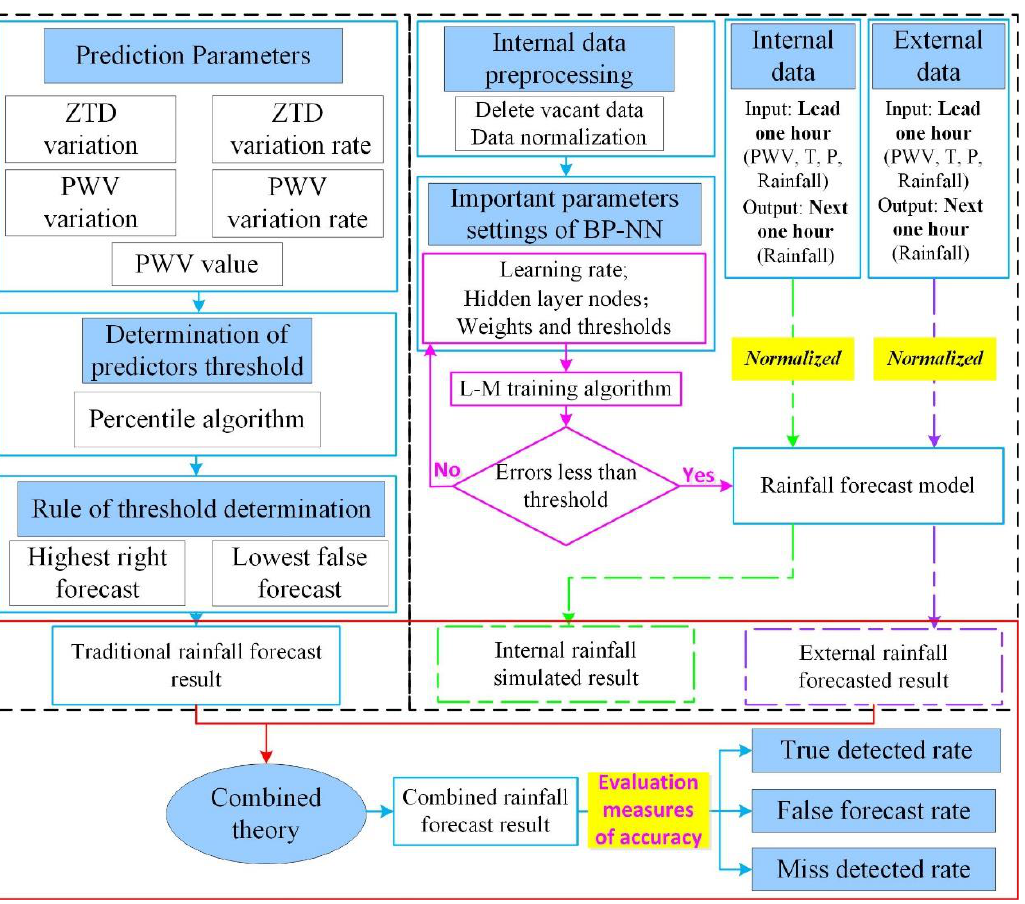
Figure 2. Flowchart for the experimental design of the short-term rainfall forecasting model based on the GNSS tropospheric parameters and BP-NN algorithm.